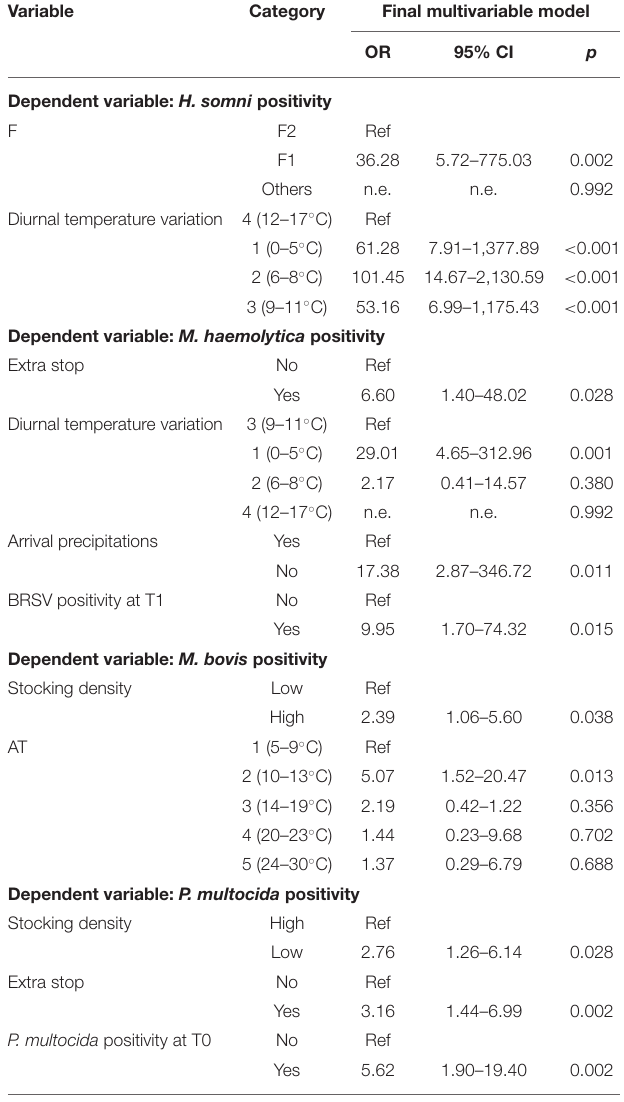
TABLE 5 | Final multivariable regression models for the dummy dependent variables of positivity/negativity to viral infections. Variable